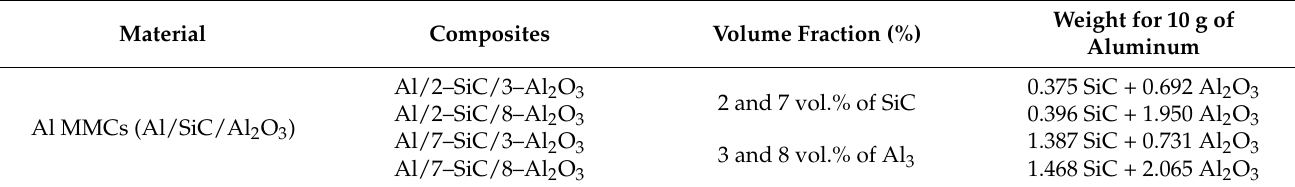
Table 2. Composition of the aluminum metal matrix